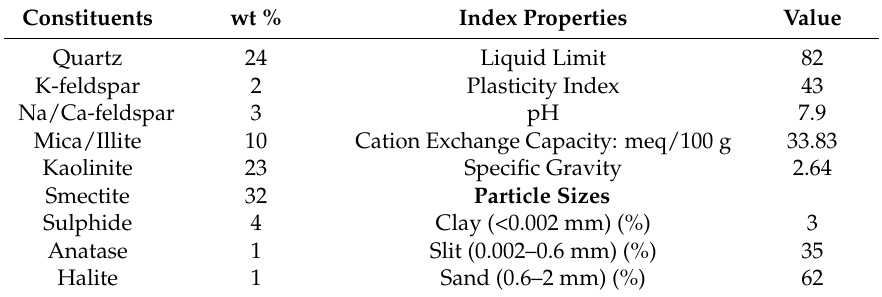
Table 1. Mineralogical constituents, index properties and grain sizes of acid sulphate soils (ASS). wt